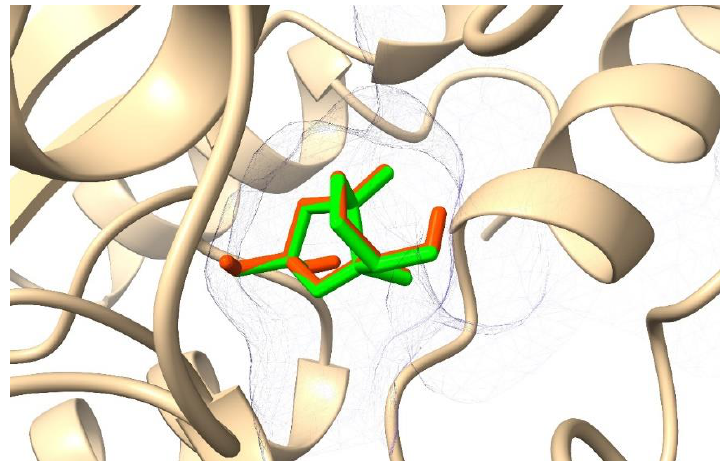
Figure 1. Comparison of the crystallographic (green) and redocked (orange red) AI2 in the binding site of the LuxP protein.